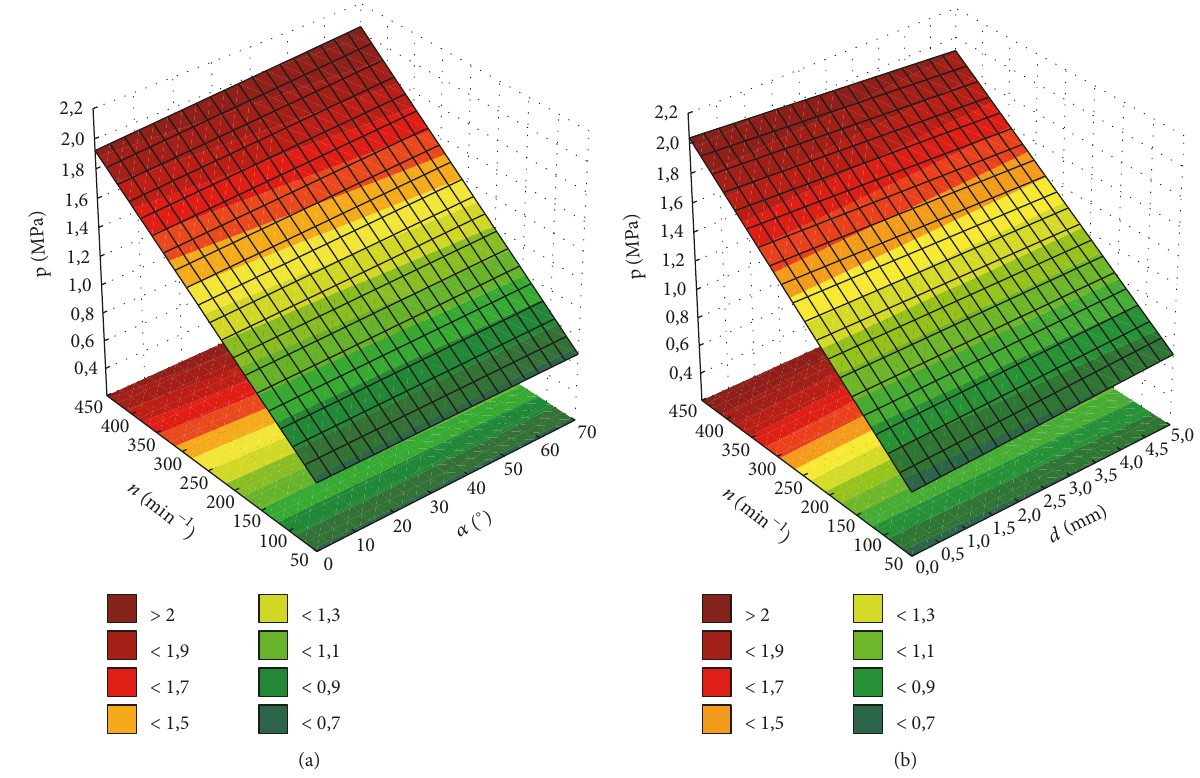
Figure 7: Model of the polymer pressure p, response surface versus the screw rotational speed n and (a) the angle between the kneading elements 𝛼 , (b) width of the gap between the kneading elements d.